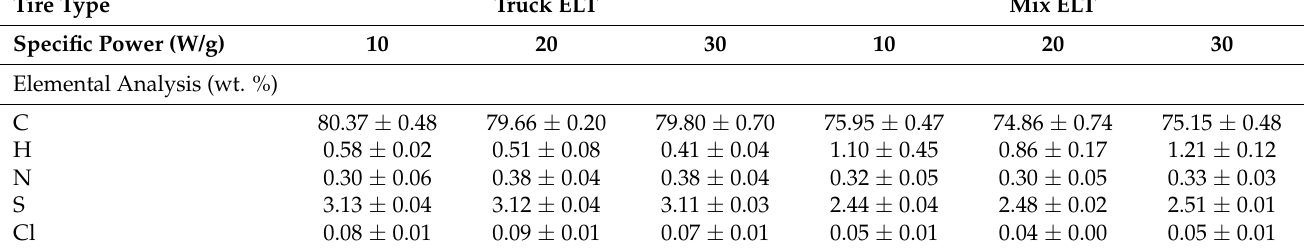
Table 5. Elemental and proximate analysis, LHV, BET surface area, and pore volume of solid sam- ples.